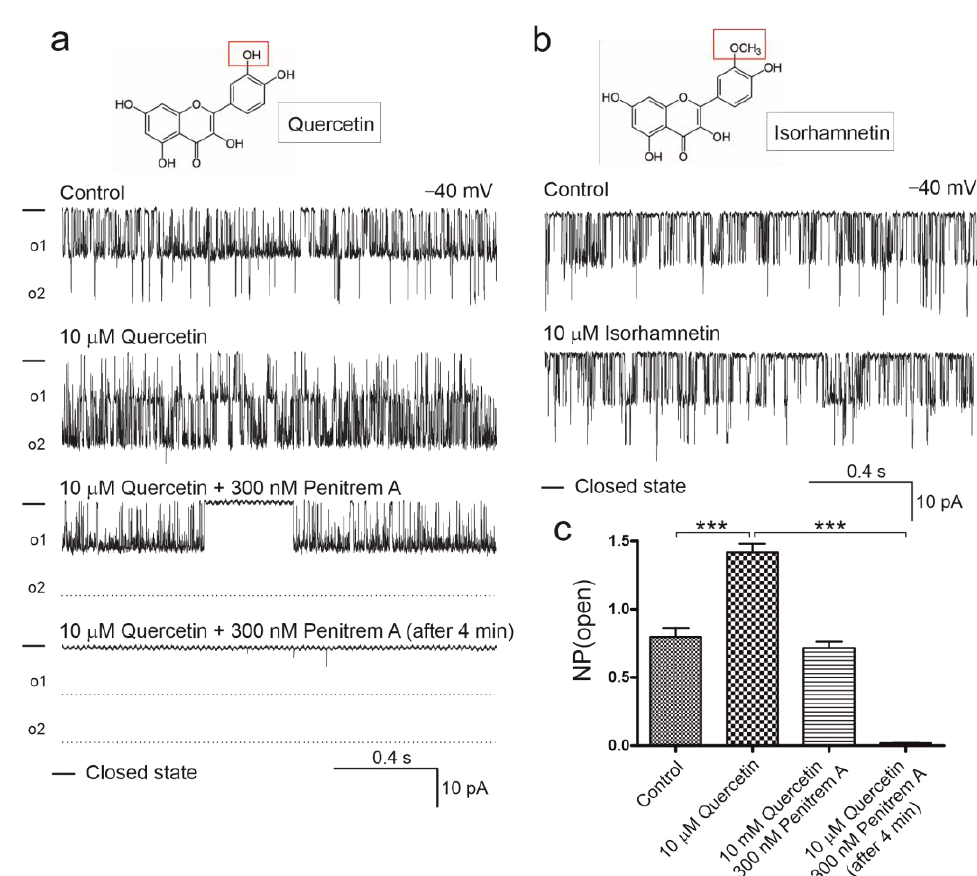
Figure 2. Assessment of mitoBK Ca channel activity after application of quercetin, isorhamnetin, and penitrem A. ( a ) Chemical structure of quercetin and single channel recordings of activating effect of 10 µM quercetin. An amount of 300 nM penitrem A inhibits the mitoBK Ca channel activity after activation by quercetin. Full inhibitory effect of penitrem A is observed after 4 min. ( b ) Chemical structure of isorhamnetin and representative recordings indicate lack of 10 µM isorhamnetin effect on mitoBK Ca channel activity. ( c ) Analysis of the mitoBK Ca channel open probability after application of quercetin at applied potential of − 40 mV (mean ± SD, n = 3). Statistical significance was determined at p < 0.001 (***) by one-way ANOVA.